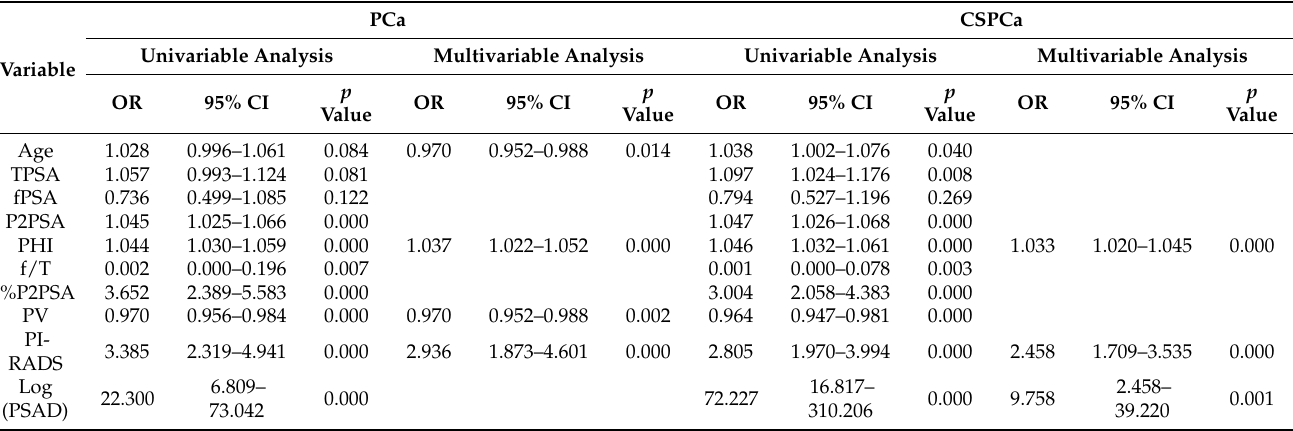
Table 4. Univariable and multivariable logistic regression analysis of risk factors for total and significant prostate cancer in the training cohort.